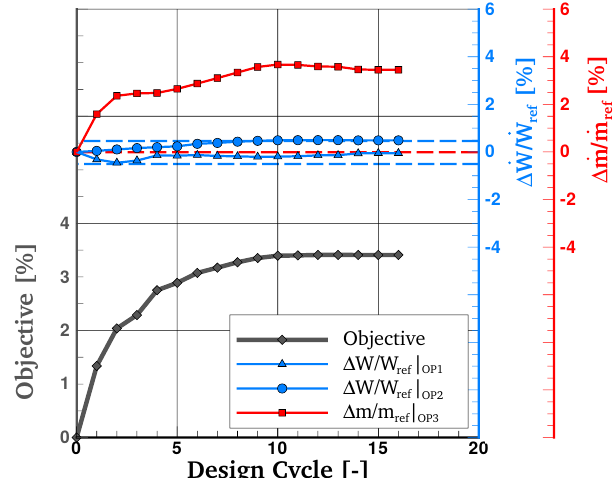
Figure 11. Optimization history including the weighted efficiency objective and the power and mass flow constraints.